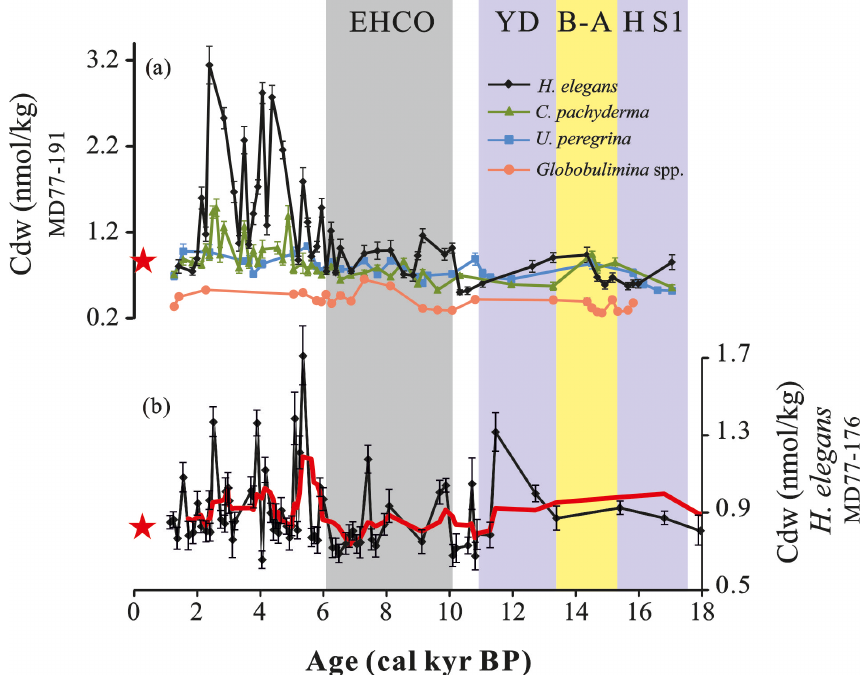
Figure 4. (a) Cd w records calculated based on the Cd / Ca of benthic foraminifera Hoeglundina elegans (black), Cibicidoides pachyderma (green), Uvigerina peregrina (blue) and Globobulimina spp. (orange) obtained from core MD77-191. (b) Cd w record from core MD77-176 reconstructed using H. elegans Cd / Ca; the red line is the smoothed curves using a two-point moving average. The red stars represent the modern Cd w ( ∼ 0 . 83nmolkg − 1 ) in the northern Indian Ocean (Boyle et al., 1995). The color-shaded intervals and abbreviations are the same as in Fig.